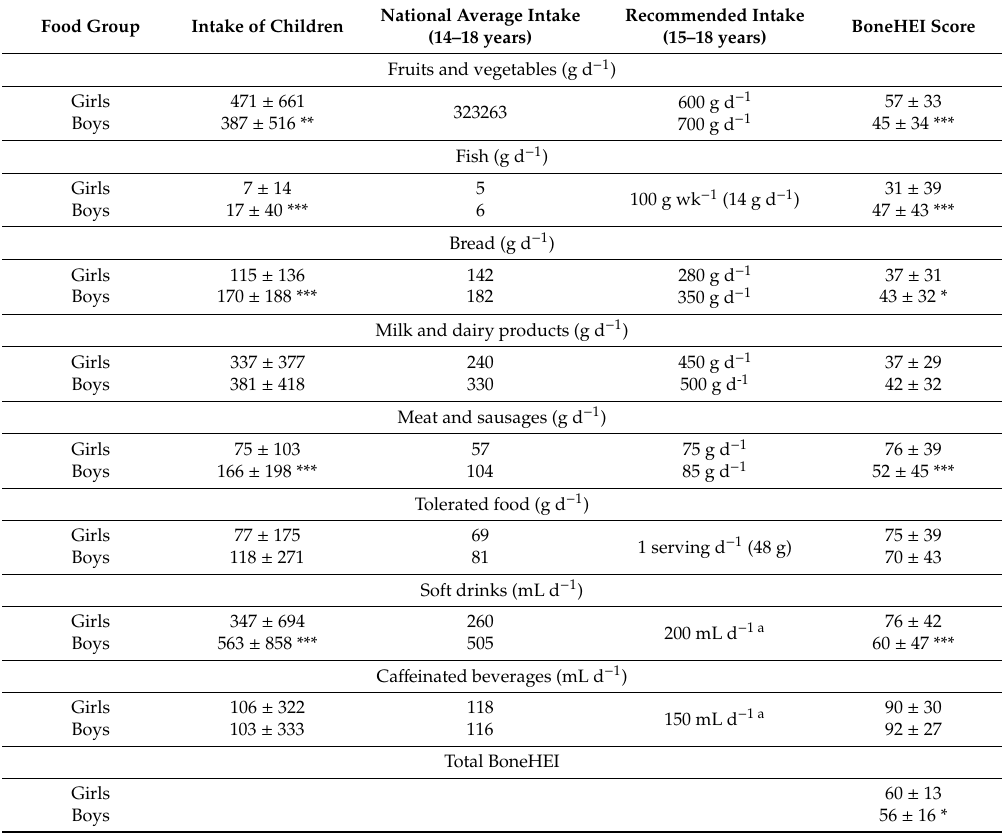
Table 3. Components of the Bone Healthy Eating Index (BoneHEI), their intake of volunteers of the present study ( n = 248 girls, n = 231 boys), the national average intake [40], and adapted dietary recommendations [37,38]. Data are presented as Mean ± SD.